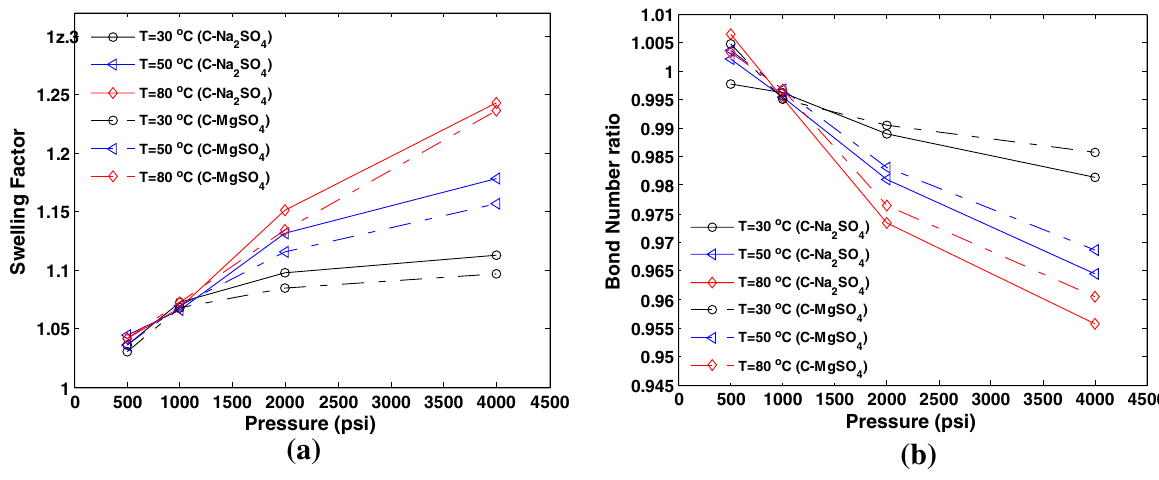
Fig. 9 Comparison of a swelling factor and b Bond number ratio in the presence of 15,000 ppm of Na ent temperature and pressure